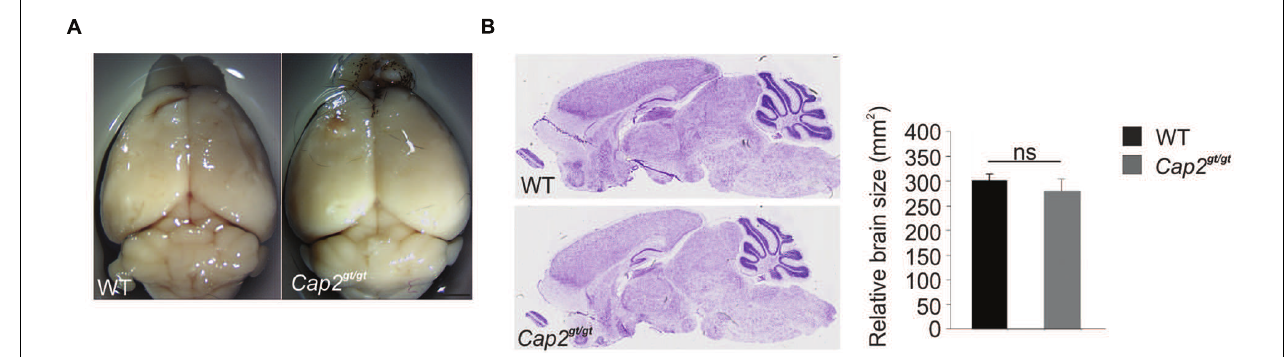
FIGURE 2 | Morphology and anatomy of Cap2 gt / gt brain. (A) Comparison of brains isolated from wild-type as well as from homozygous Cap2 gt / gt mice does not reveal differences in the size of the brain (upper panel). Scale bar, 1 mm. (B) Nissl staining of sagittal sections and its graphical analysis from control and mutant brains (middle panel) does not show any significant difference in gross anatomy of brain WT: 300 ± 13 mm 2 , n = 10 sections from 3 mice; Cap2 gt / gt : 280 ± 22 mm 2 , n = 10 sections from 3 mice, p > 0.05. Scale bar, 250 µ